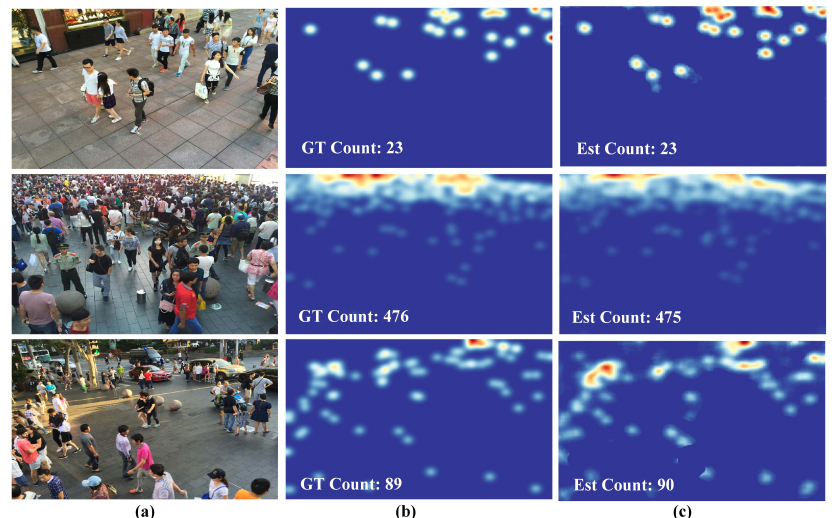
Figure 4. Density estimation results on the ShanghaiTech Part A [8]. ( a ) Input images, ( b ) ground truth density maps, and ( c ) estimation results.